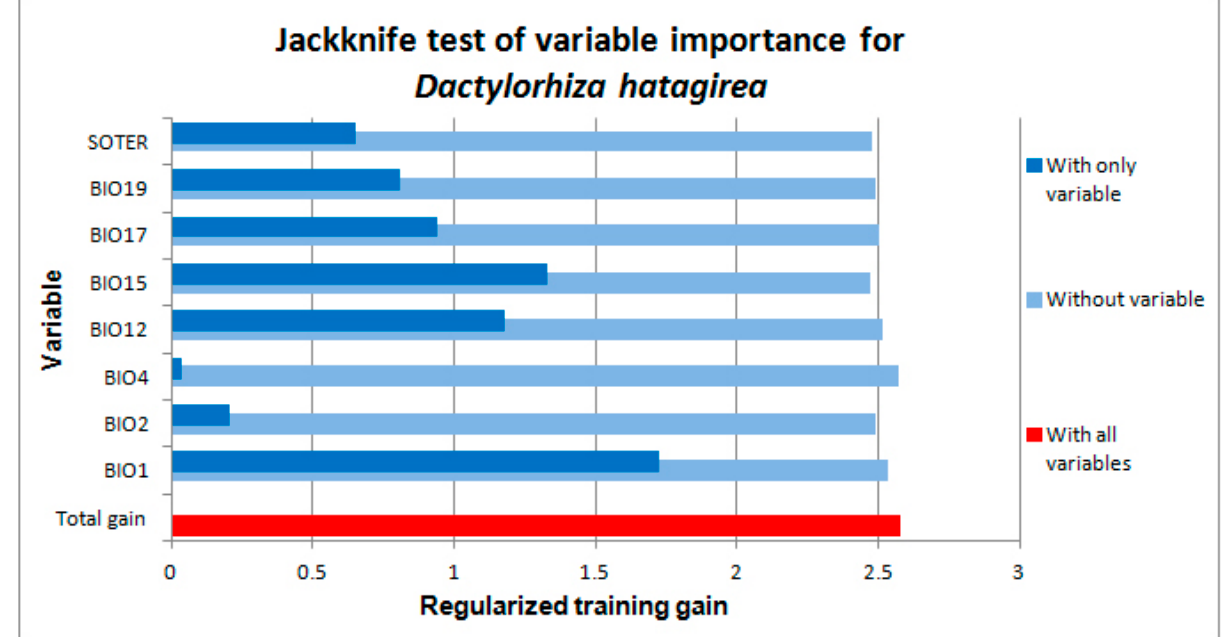
Figure 1. Results of the jackknife test of the importance of the environmental variables to be used in the development of the Maxent model of Dactylorhiza hatagirea . The length of the dark-blue bar indicates the size of the impact of the selected variable, and the length of light-blue bar shows how much of the explanatory power of the model would be lost if the corresponding factor were excluded from the analysis. See Table 1 for full names of the variables on the y-axis.